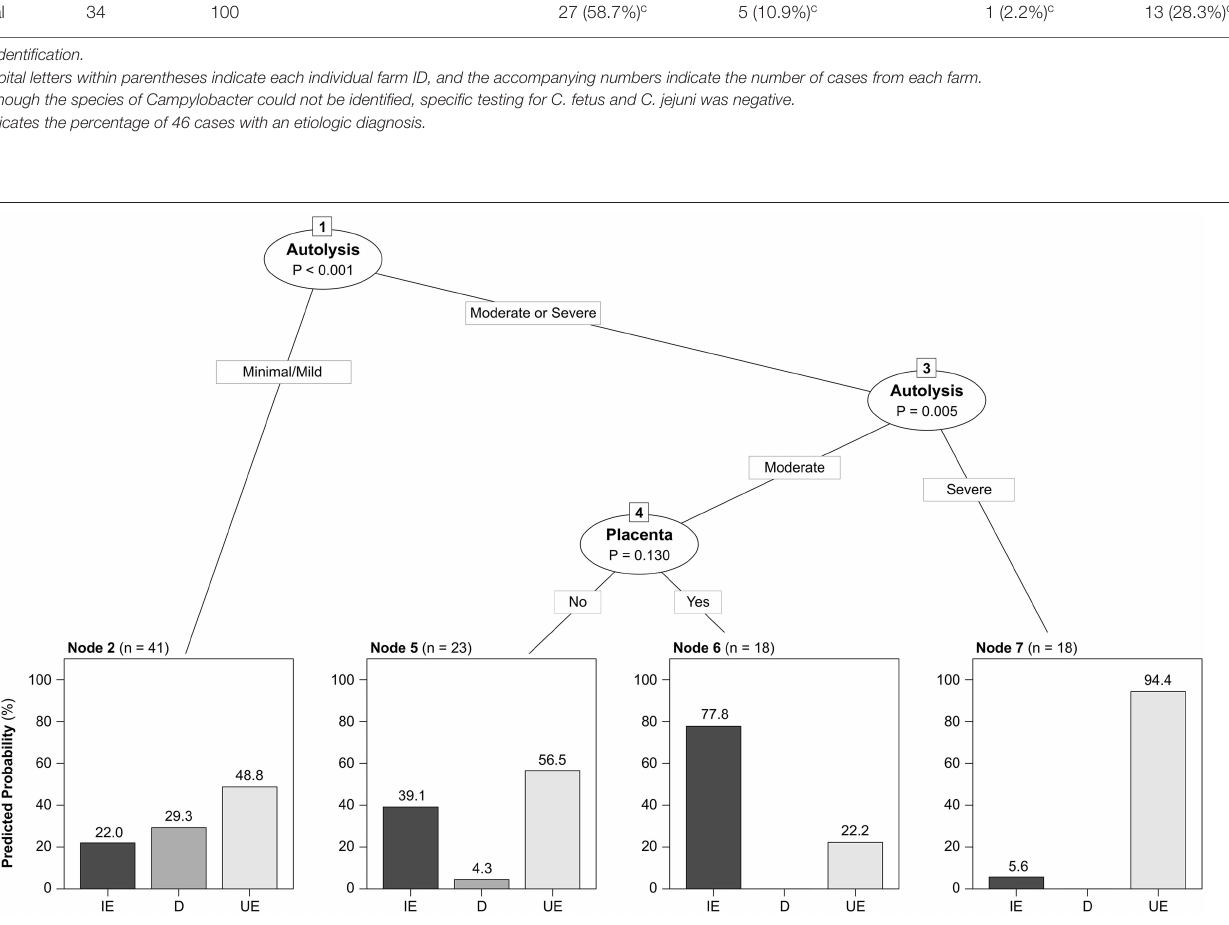
Frontiers in Veterinary Science |